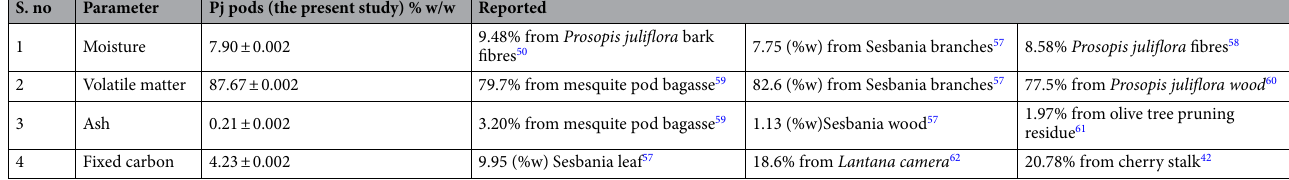
Table 1. Proximate analysis of Pj pods on a dry